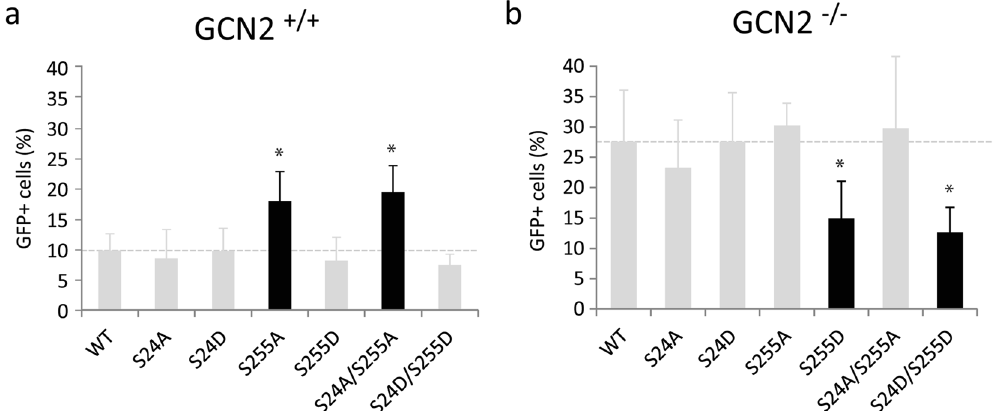
Figure 9. Infectivity of HIV-1-based vector in GCN2 − / − and GCN2 + / + MEF cells. MEF cells WT (GCN2 + / + ) ( a ) or knock out for GCN2 (GCN2 − / − ) ( b ) were transduced with a M.O.I. of 1 for 48 hours. The percentage of transduced cells was determined by flow cytometry. The data are the results of at least three independent experiments. Student’s t -test * p < 0.05.